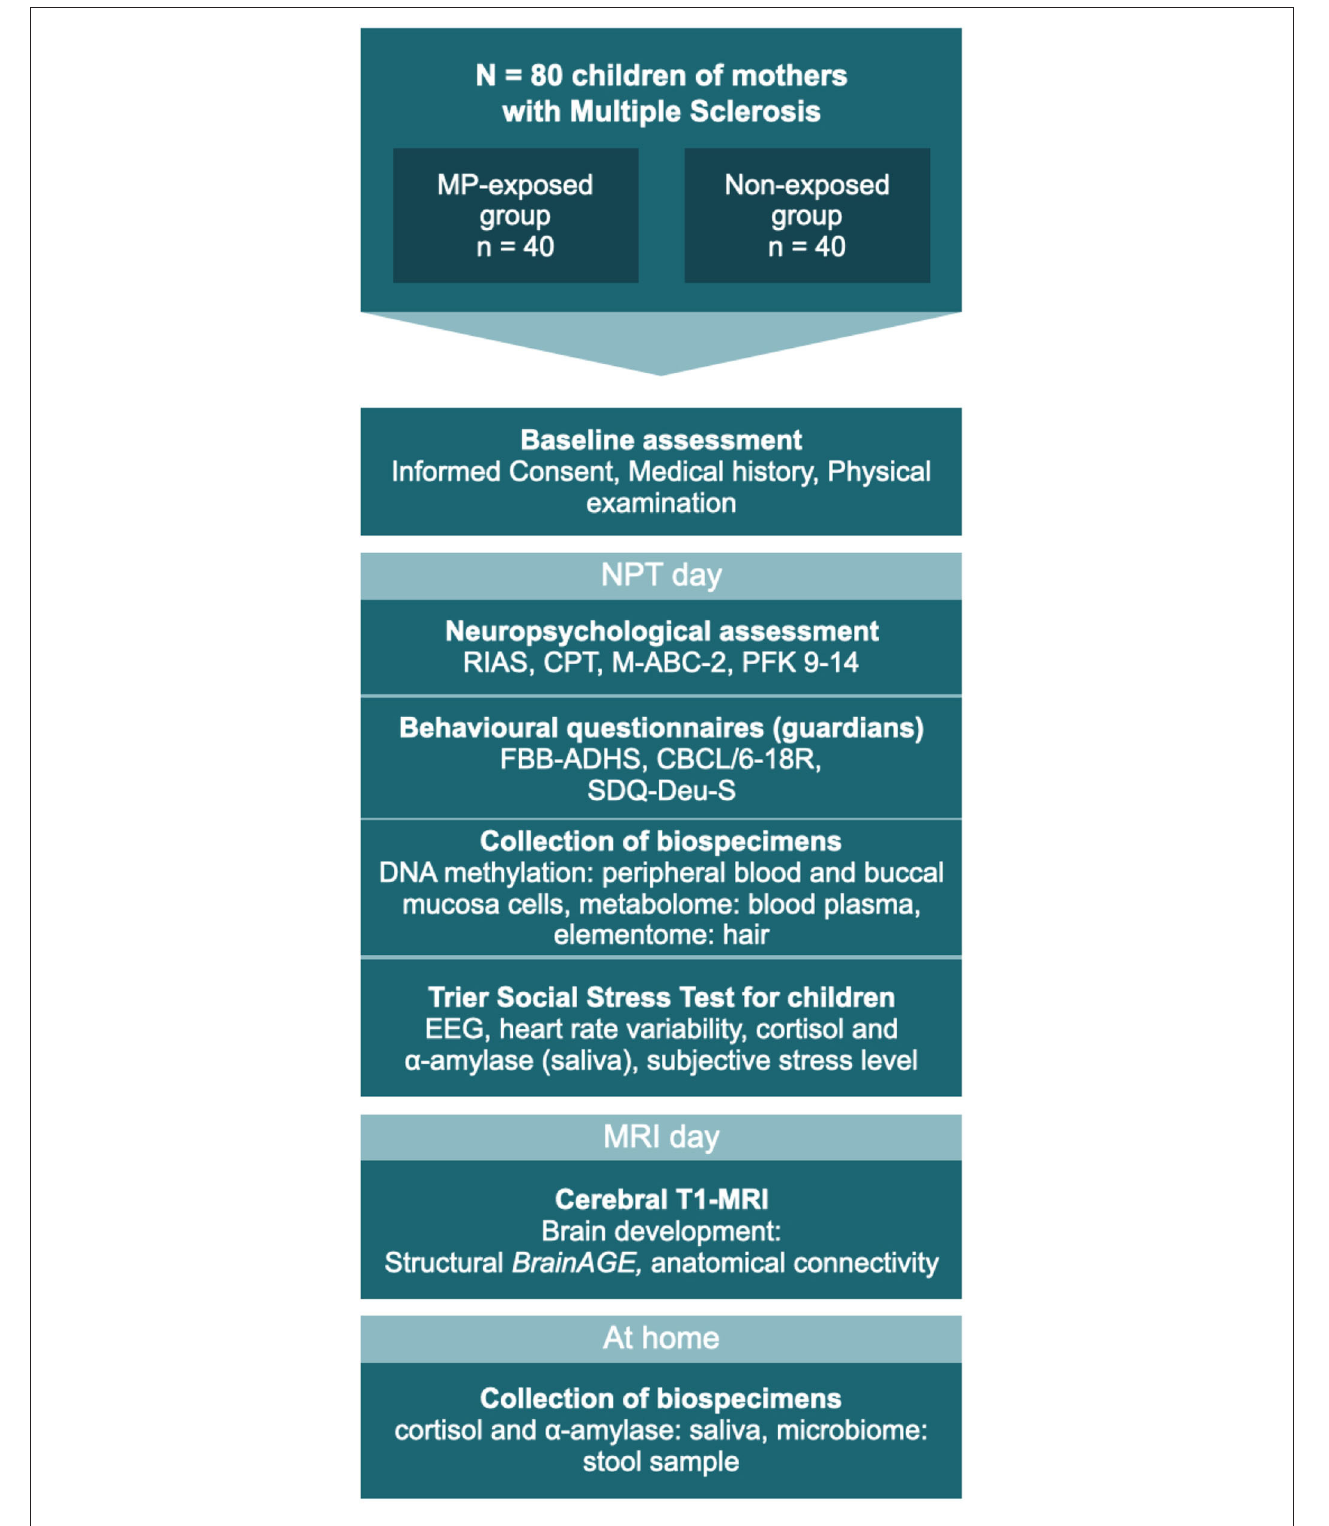
FIGURE 1 | The two study days: testing sequence for all participants. MP, methylprednisolone; NPT, Neuropsychological testing; RIAS, Reynolds Intellectual Assessment Scales and Screening; CPT, Continuous Performance Test; M-ABC-2, Movement Assessment Battery for Children – Second Edition; PFK 9-14, German personality questionnaire; FBB-ADHS, German questionnaire for attention deficit hyperactivity disorder; CBCL/6-18, Child Behavior Checklist for children aged 6–18 years; SDQ-Deu-S, Strengths and Difficulties Questionnaire. MRI and NPT days may occur in reverse order.